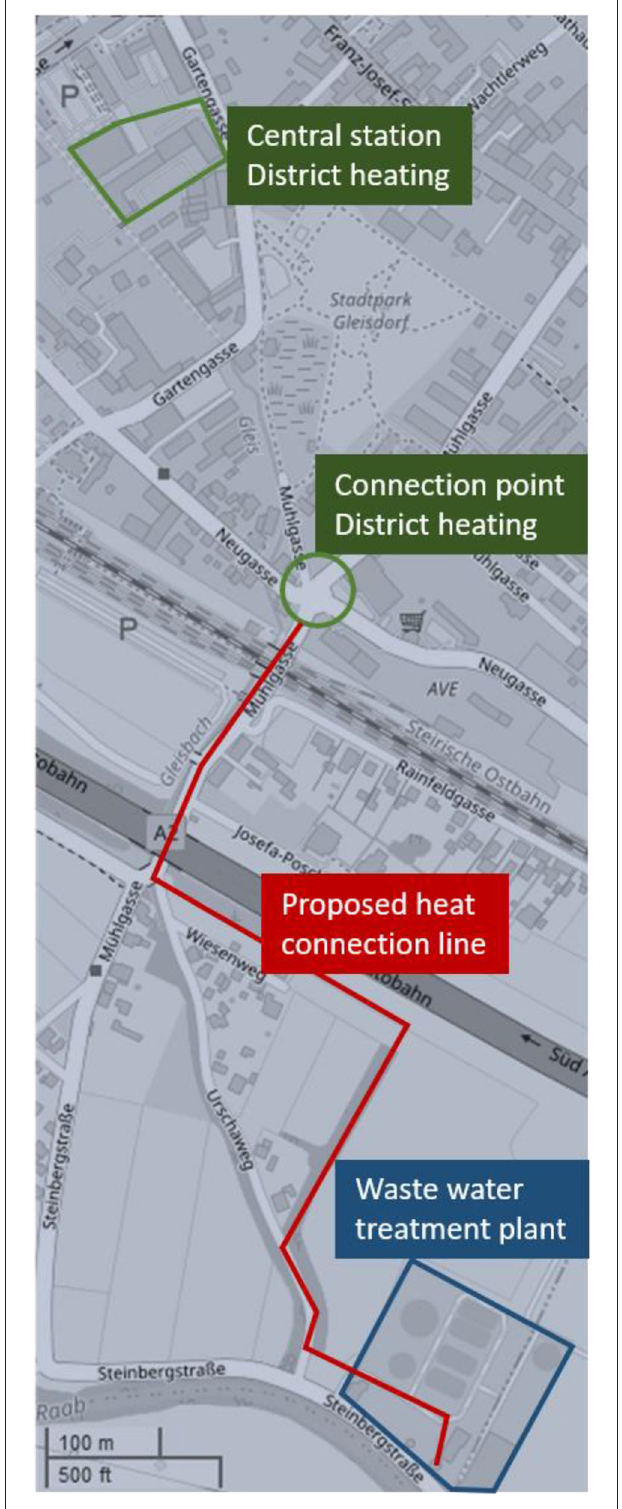
FIGURE 3 | Heat connection line from wastewater treatment plant to the connection point of district heating network (OpenStreetMap, own drawing).